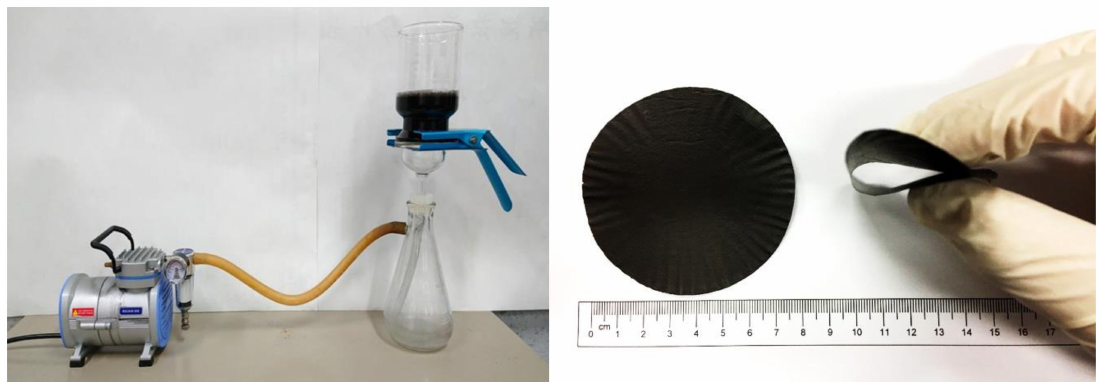
Figure 1. Experimental setup of the vacuum filtration and as-prepared hybrid